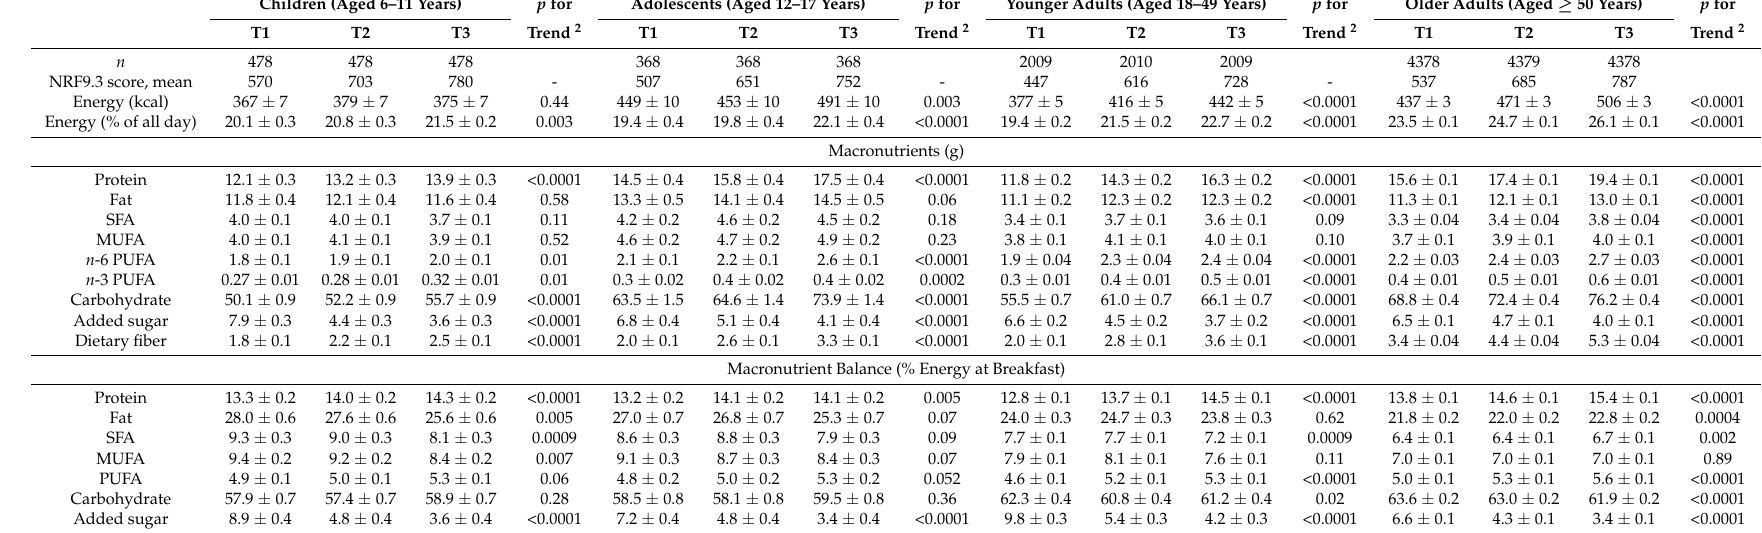
Table 2. Intakes of energy and macronutrients at breakfast among breakfast consumers according to tertile (T) category of the Nutrient-Rich Food Index 9.3 (NRF9.3) score as a measure of overall diet quality 1